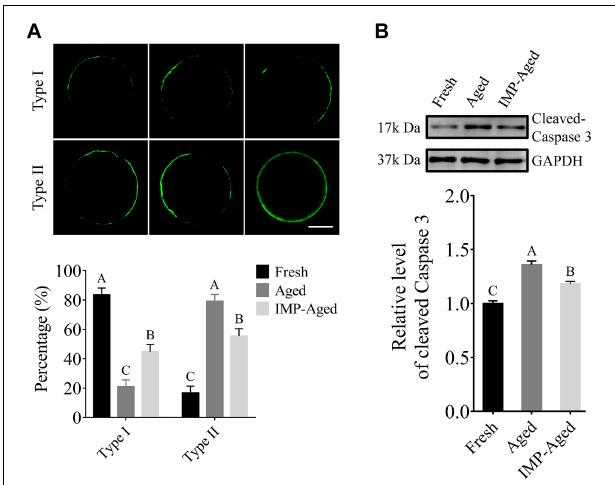
FIGURE 3 | IMP treatment reduced apoptosis in aged oocytes. (A) Representative images of Annexin-V staining and proportion of Type I/II oocytes in fresh ( N = 246), aged ( N = 217), and IMP-treated aged ( N = 235) groups. Scale bar = 25 µ m. Significant differences are represented by different capital letters ( P < 0.01). R = 3. (B) Cleaved-Caspase 3 level in fresh, aged, and IMP-treated aged groups. Significant differences are represented by different capital letters ( P < 0.01). R =